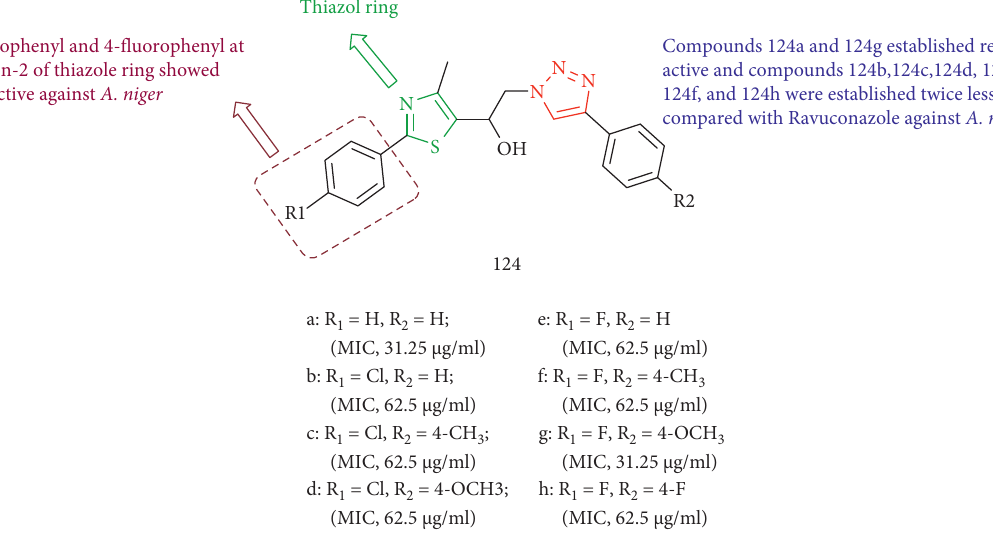
Figure 59: Chemical structure of 1-(4-methyl-2-aryl-1,3-thiazol-5-yl)-2-(4-aryl-1,2,3-triazol-1- yl)ethanol.